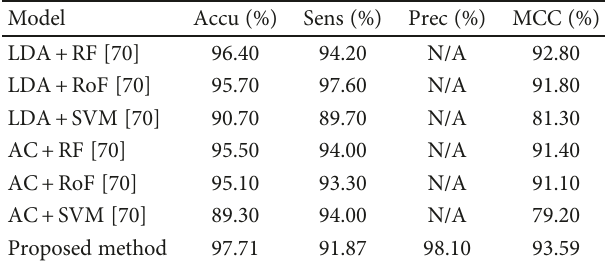
Figure 6: ROC curves performed by the SVM-based approach on the S. cerevisiae dataset. Table 5: Performance comparison of di ff erent methods on the human